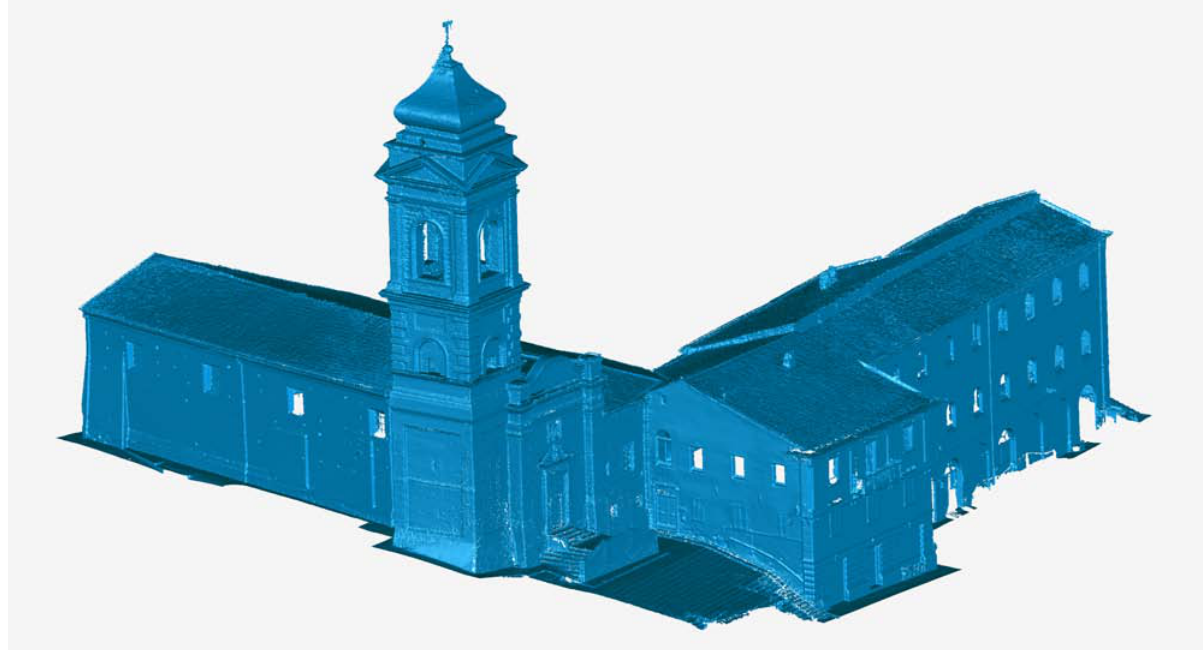
Figure 11. 3D model obtained using wrap method in